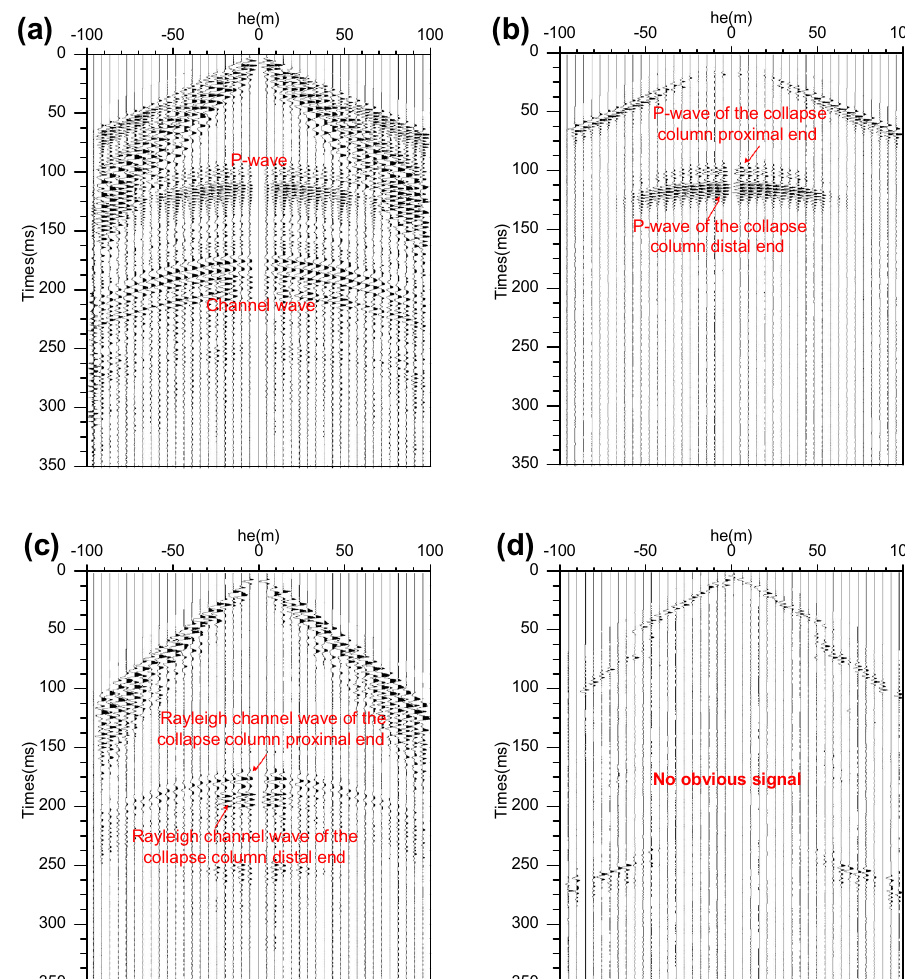
Fig. 10 Different types of No. 21 CSP gathers of the